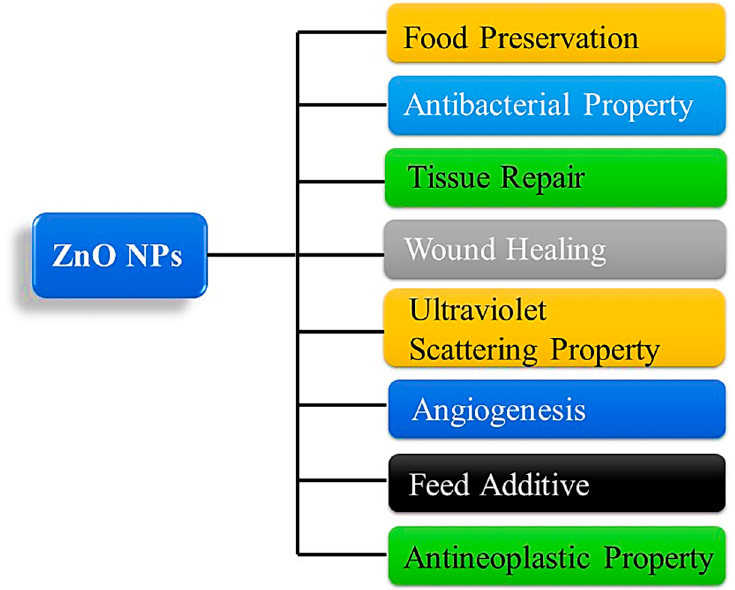
Figure 1. Schematic diagram of common applications of ZnO NP. ZnO, zinc oxide; NPs, nanoparti- cles.